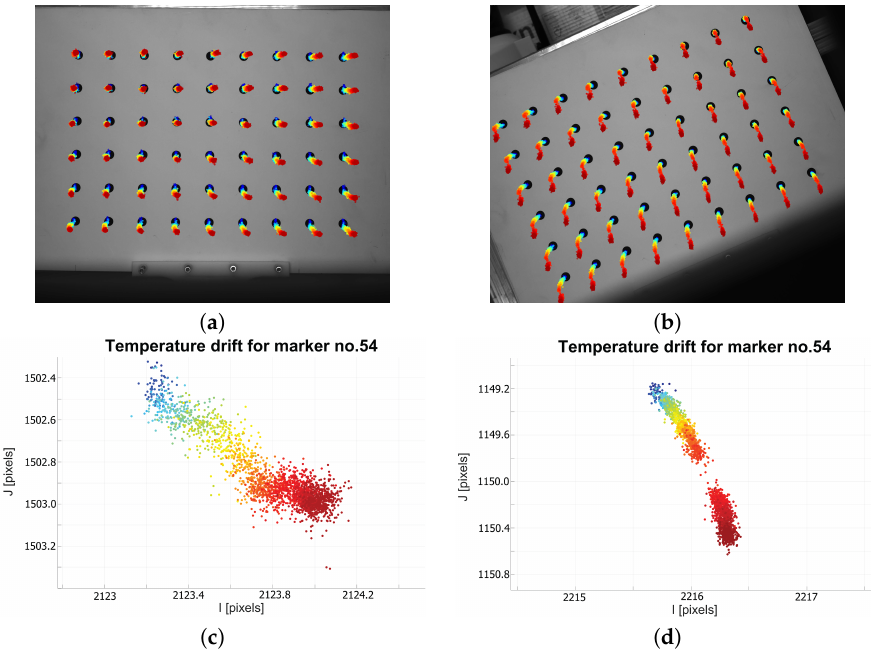
Figure 4. The observed image drift for normal ( a ) and rotated ( b ) camera (Pointgrey Grasshopper 2) positions. The background image is the first captured frame. Colored dots (blue for reference temperature—the coolest) represent the next location of calculated marker centers. Each subsequent coordinate was multiplied by a factor of × 100 for better visualization. Graphs ( c , d ) represent the temperature drift, in normal ( c ) and rotated ( d ) camera positions, for marker no. 54.